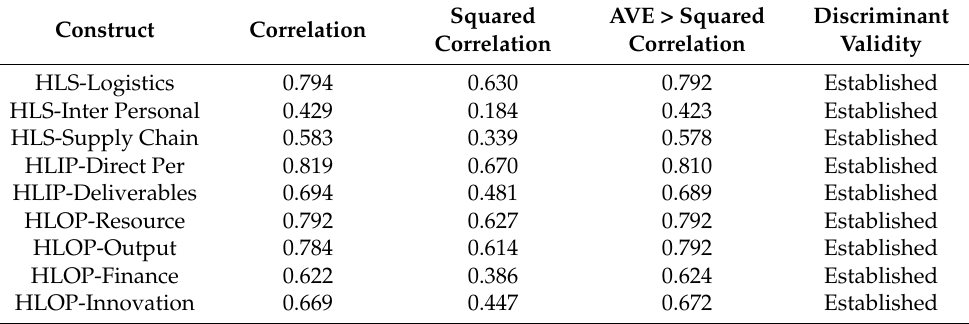
Table 8. Discriminant